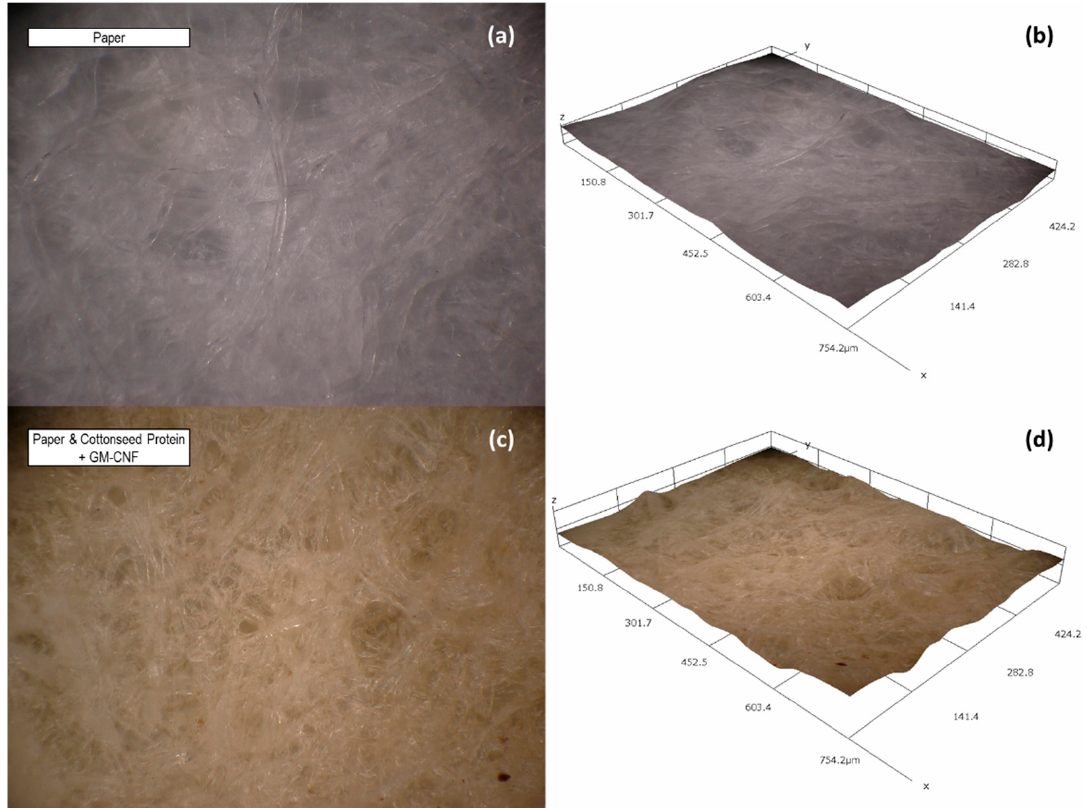
Figure 3. ( a ) 3D composite image (400×) of paper and ( b ) 3D-layered topographical map (400×); ( c ) 3D composite image (400×) of paper treated with cottonseed protein and cotton gin mote cellulose nanofibers and ( d ) 3D layered topographical map (400×).